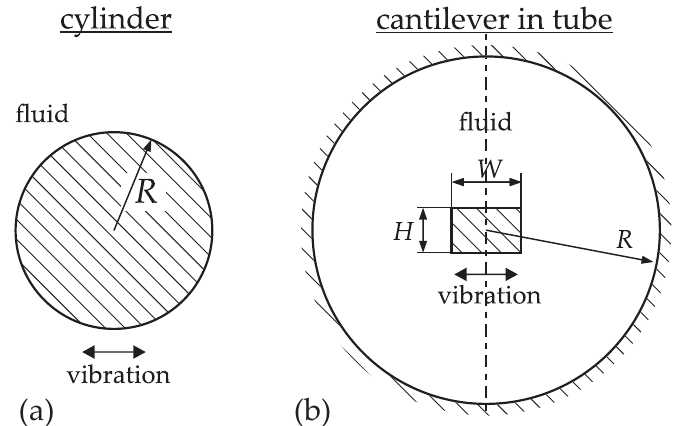
Figure 1. Prismatic beam with cylindrical cross-section ( a ) and a cantilever vibrating in a tube ( b ) as examples for a simple and a complex geometry of a vibrating